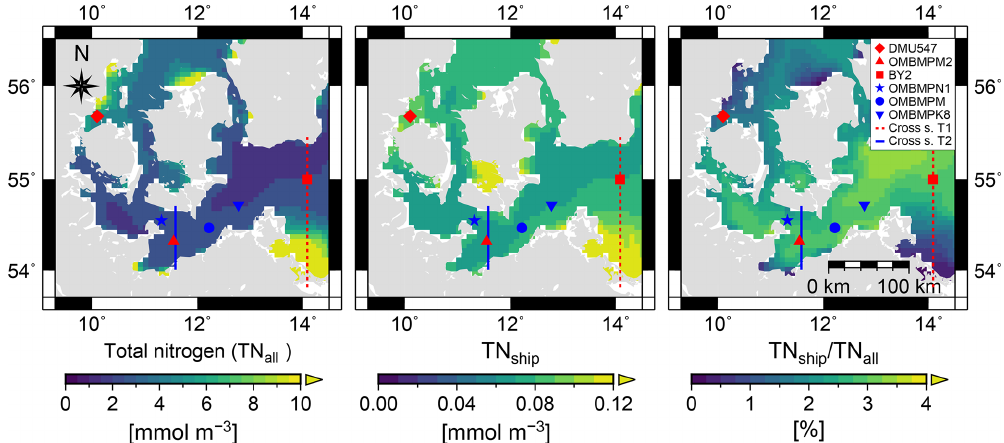
Figure 7. Spatial pattern of the modeled total nitrogen concentration (TN all ), the total nitrogen concentration with nitrogen from shipping- related atmospheric deposition (TN ship ), and the ratio of the two (TN ship / TN all ). Modeled data for the year 2012 of the top 10m are used. Measurement stations and cross sections used in other parts of the evaluation are included as symbols and lines,